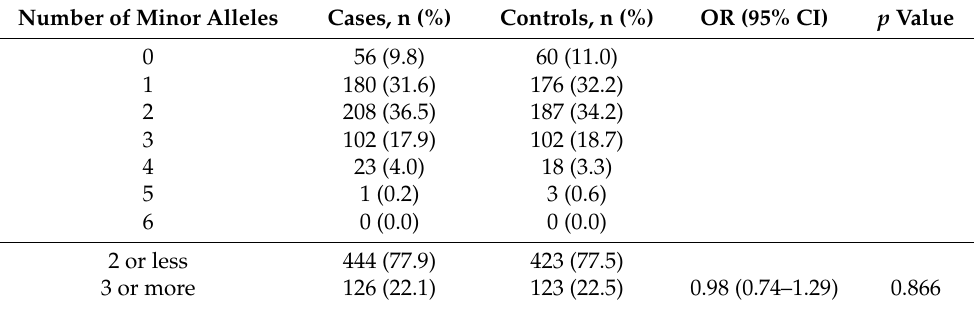
Table 3. Distribution of combinations of minor (risk)